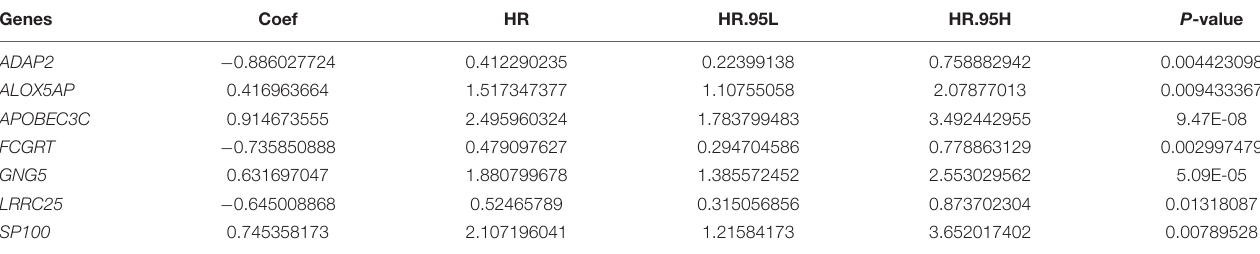
TABLE 2 | Results of the seven key genes in the multivariable Cox regression analysis. Genes